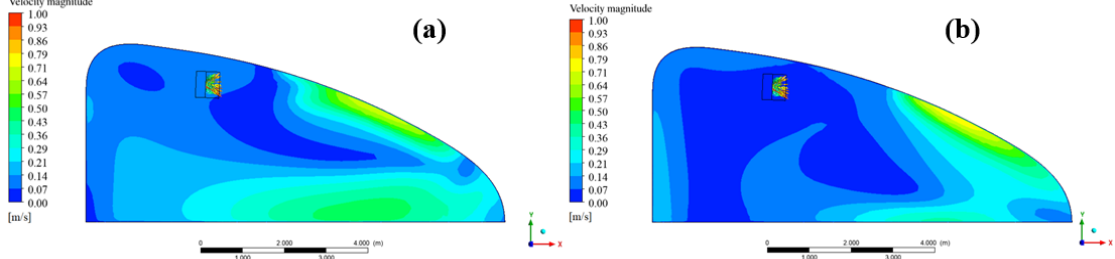
Figure 13. Velocity distribution contours for vertical profiles when the fan tilt angle was − 2.5°: plane A ( a ) and plane C ( b ).